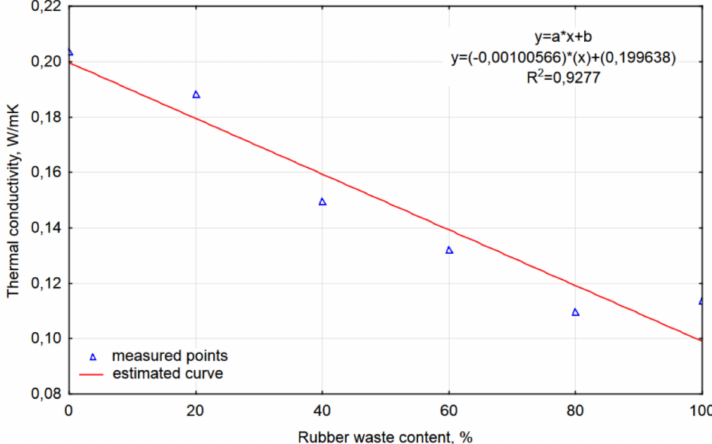
Figure 7. Graph of the function describing the dependence of the heat transfer coefficient on the percentage share of waste in the mortar.